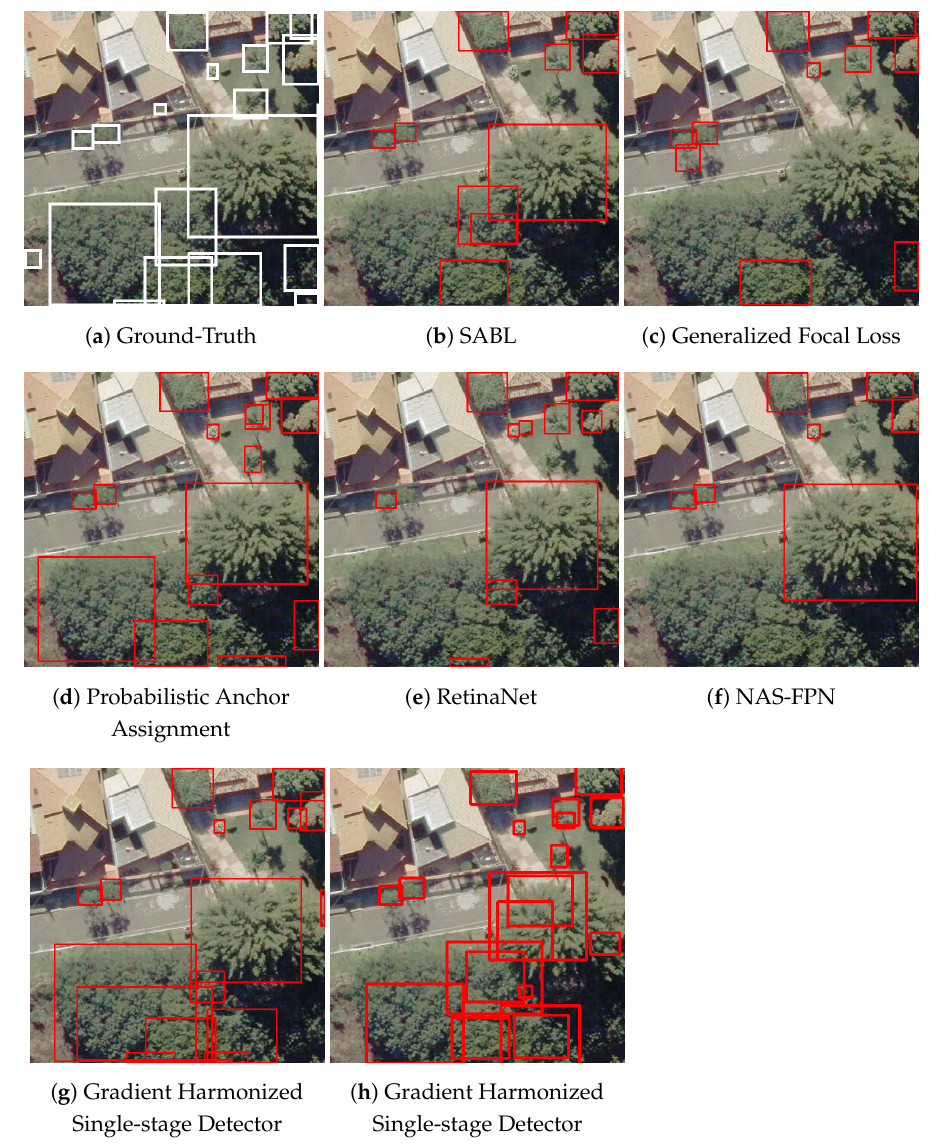
Figure 6. Examples of tree detection in areas with high density using the one-stage